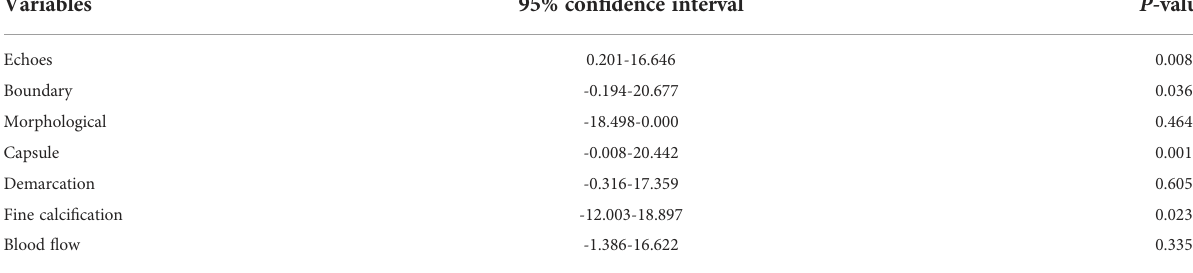
TABLE 3 Multivariate logistic regression analysis of ultrasonic signs in 3D-TRUS group. Variables